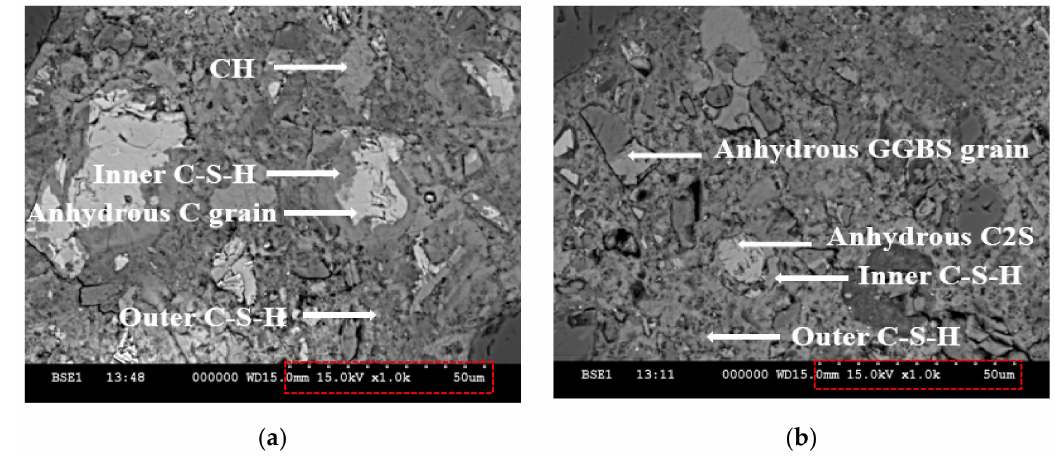
Figure 16. SEM observations after 56 curing days of ( a ) control mix and ( b ) mix 50C35GGBS15CS.